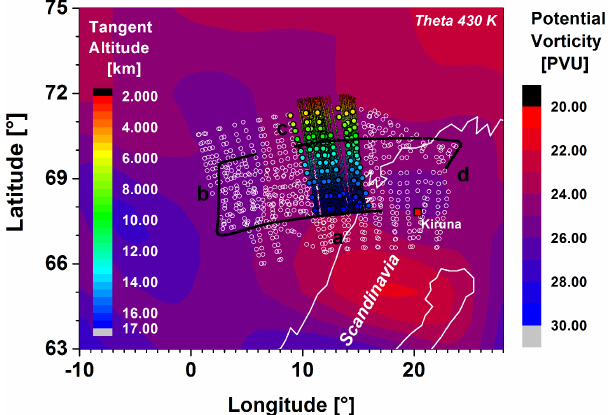
Figure 2. Vertical flight profile of the Geophysica (grey line), ver- tical distribution of the MIPAS-STR observations (black dots) and interpolated cloud index for the flight on 16 December 2011. Blue vertical lines indicate the time window of the presented GLORIA chemistry mode observations. Grey hatched areas indicate turns per- formed by the Geophysica between the different flight